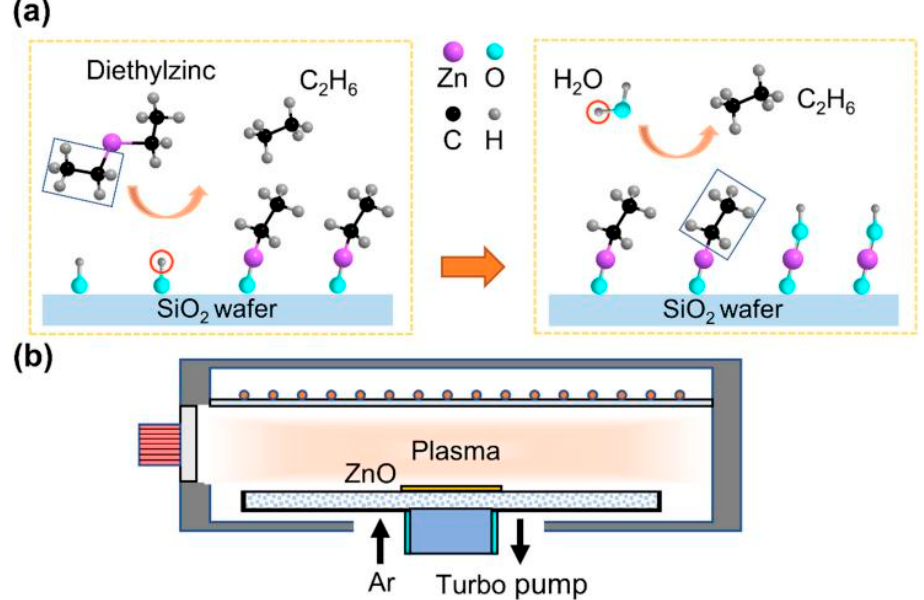
Figure 25. ( a ) ALD deposition process; ( b ) Ar plasma treatment [158].